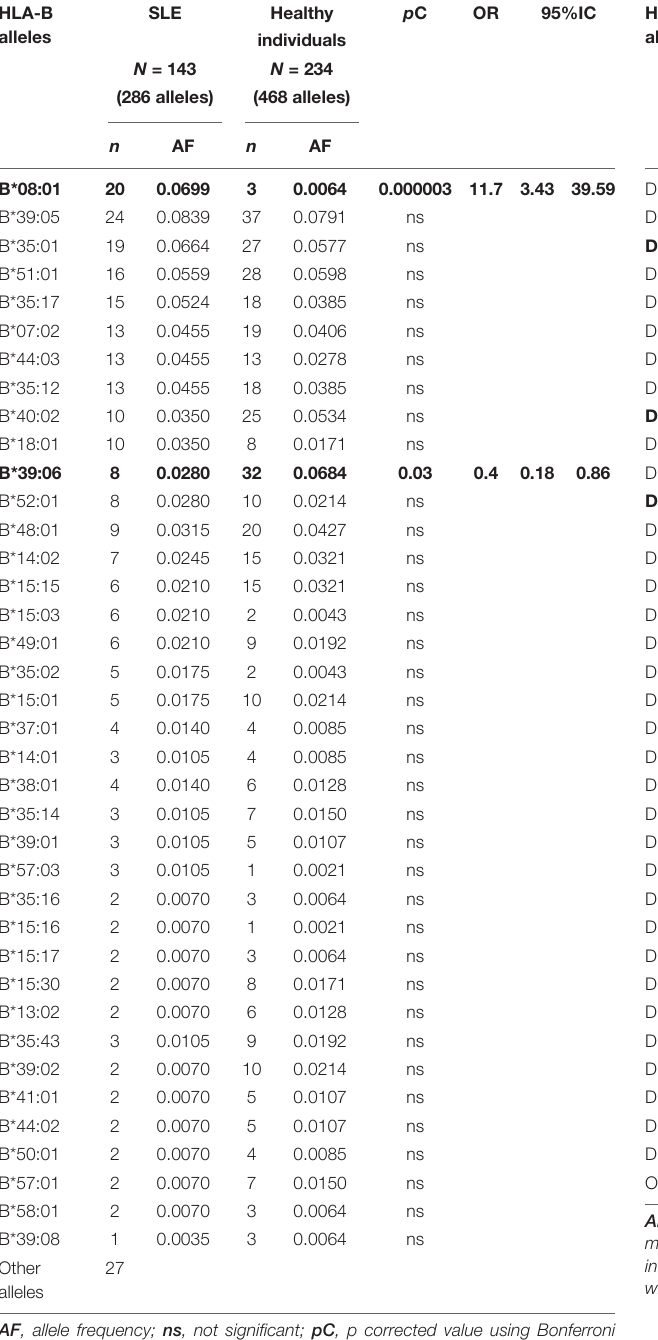
TABLE 4 | Human leukocyte antigen-DRB1 allele frequencies in SLE patients and healthy individuals. HLA-DRB1